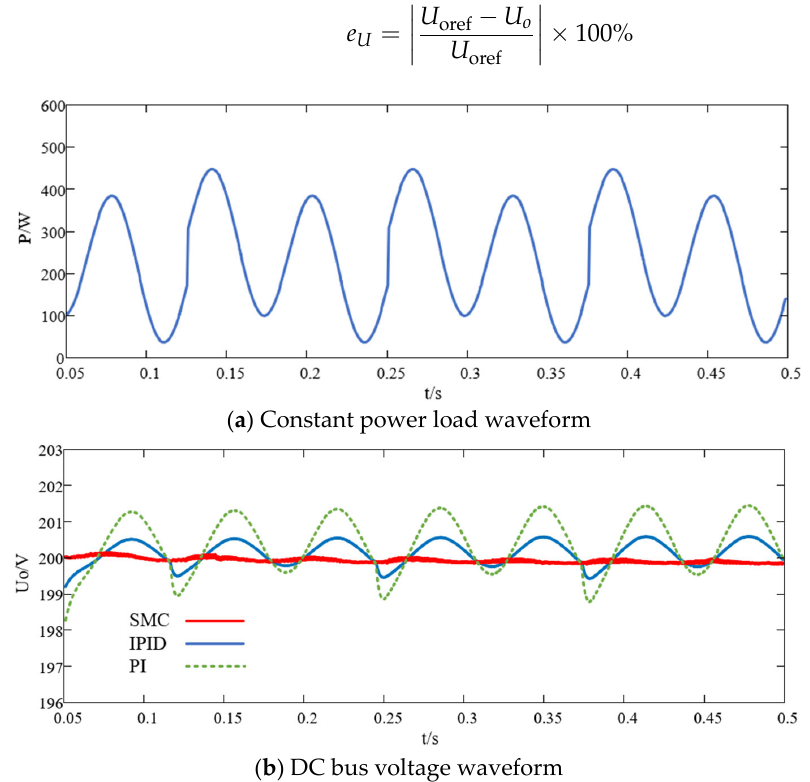
Figure 6. State response under continuous load changes, ( a ) Constant power load waveform, ( b ) DC bus voltage waveform.